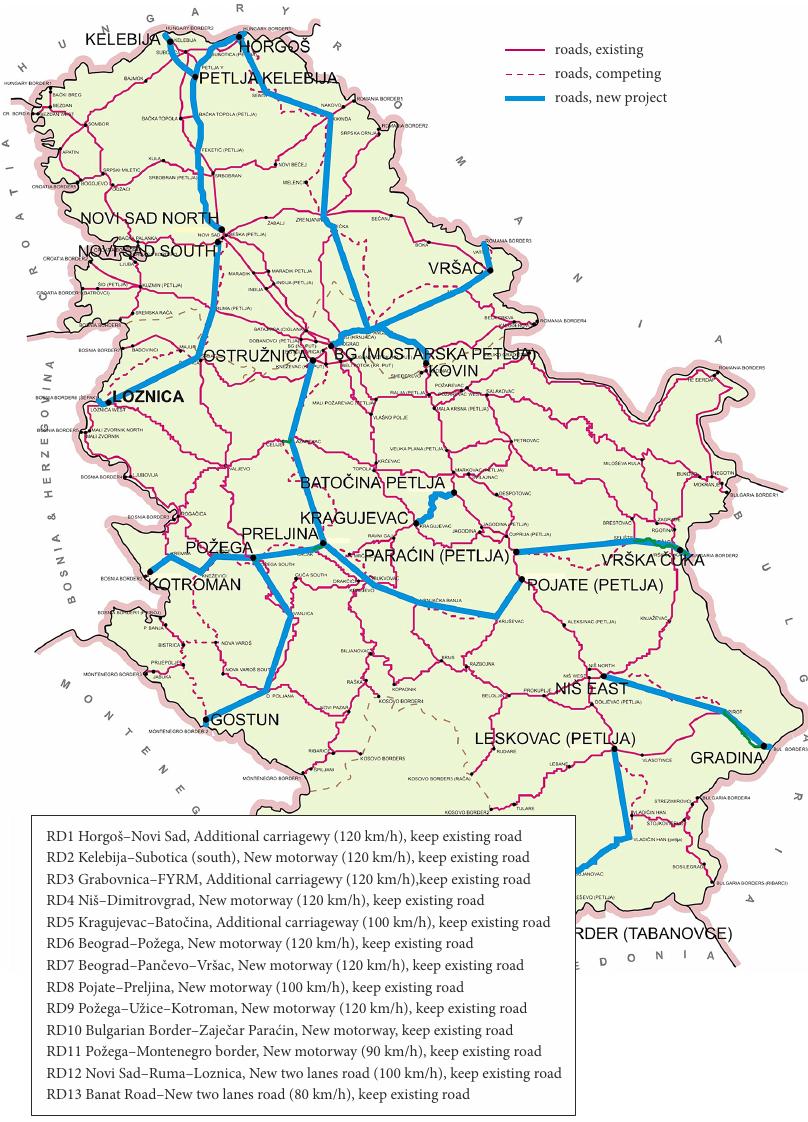
Figure. Potential road developmental projects applied for scenario OS2030 Table 1. Regression coefficients for determining fuel consumption of diesel bus